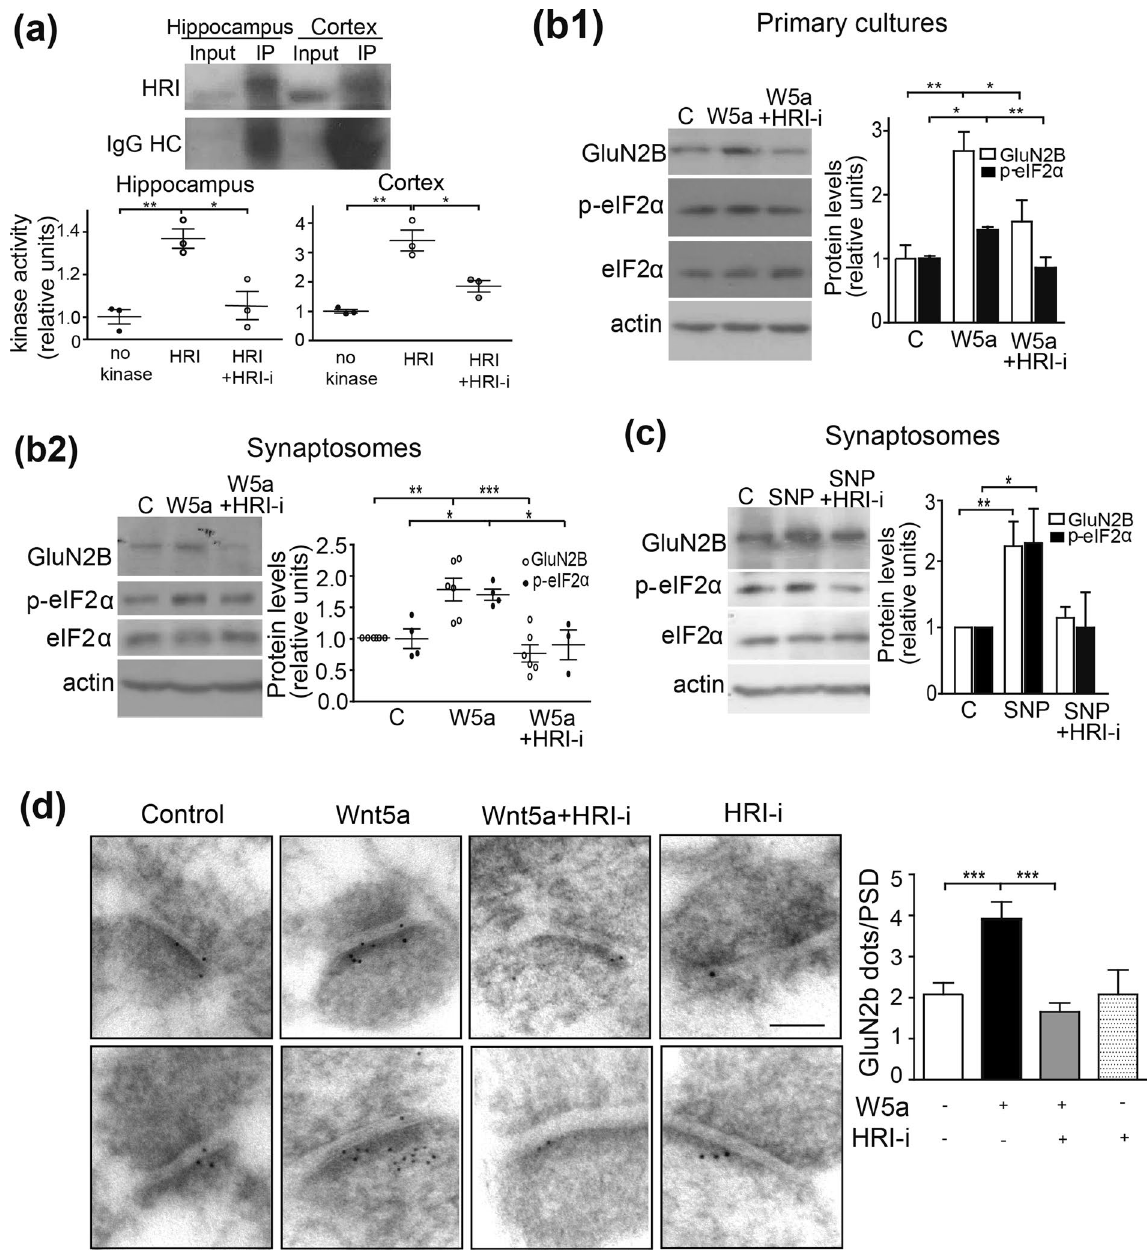
Figure 3. Wnt5a mediates GluN2B expression through HRI kinase activation. ( a ) Blot showing immunoprecipitated HRI kinase from mouse hippocampus and cortex. Graphs at bottom show the fold kinase activity of the immunoprecipitated kinase in the presence or absence of the HRI inhibitor, measured by luciferase signal. Lines show the mean ± SEM. N = 3 independent animals. (* p 0.05, ** p < 0.001) p = 0.0041 (hippocampus) p = 0.001 (cortex). ( b ) Western blots of primary cultures (b 1 ) or synaptosomes (b 2 ) ( c ) after treatment with control, Wnt5a (W5a) medium or nitric oxide donor sodium nitroprusside (SNP) or co-incubation with Wnt5a, SNP and HRI-i. N = 8 (GluN2B)-7 (eiF2α) independent experiments (primary cultures), N = 6 (GluN2B)—4 (eiF2α) independent experiments (Wnt5a treated synaptosomes) and N = 5 (GluN2B)—7 (eiF2α) respectively ±SEM. (* p 0.05, ** p < 0.001, *** p < 0.90005), p = 0.0021 (GluN2B in primary cultures): p = 0.0004 (eIF2α in primary cultures); p = 0.0003(GluN2B in Wnt5a treated synaptomes) ; p = 0.0131(eIF2α in Wnt5a treated synaptosomes); p = 0.0108 (GluN2B in SNP treated synaptomes); p = 0.0531 (eIF2α in SNP treated synaptosomes). ( d ) EM images from the CA1 region of hippocampal slices with immunogold against GluN2B subunit. Graph shows quantification of the gold particles in the postsynaptic area. Scale bar: 100 nm. Lines show the mean ± SEM. N = 3 independent animals; Control (85); Wnt5a (76); Wnt5a+HRI-i (107); HRI-i (24) photos (*** p = 0.00009). Full-length gels are presented in Supplementary Fig.